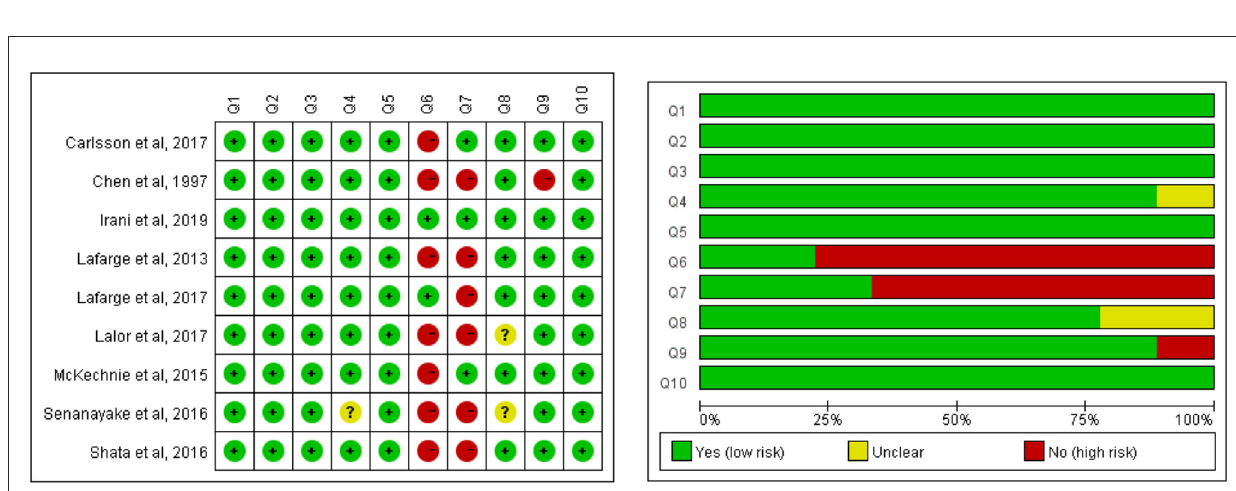
FIGURE3 Methodological quality of qualitative studies. Q1: Was there congruity between the stated philosophical perspective and the research methodology? Q2: Was there congruity between the research methodology and the research question or objectives? Q3: Was there congruity between the research methodology and the methods used to collect data? Q4: Was there congruity between the research methodology and the representation and analysis of data? Q5: Was there congruity between the research methodology and the interpretation of results? Q6: Was there a statement locating the researcher culturally or theoretically? Q7: Was the influence of the researcher on the research, and vice-versa, addressed? Q8: Were participants, and their voices, adequately represented? Q9: Was the research ethical according to current criteria or, for recent studies, and is there evidence of ethical approval by an appropriate body? Q10: Did the conclusions drawn in the research report flow from the analysis, or interpretation, of the